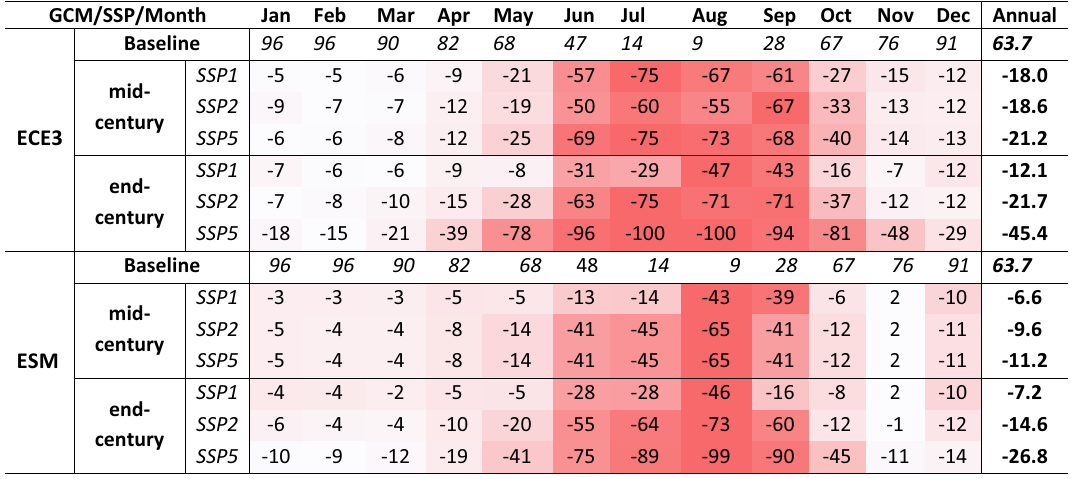
Table 3. Percentage changes in mean monthly future SCA relative to the baseline for all scenarios based on both GCMs.